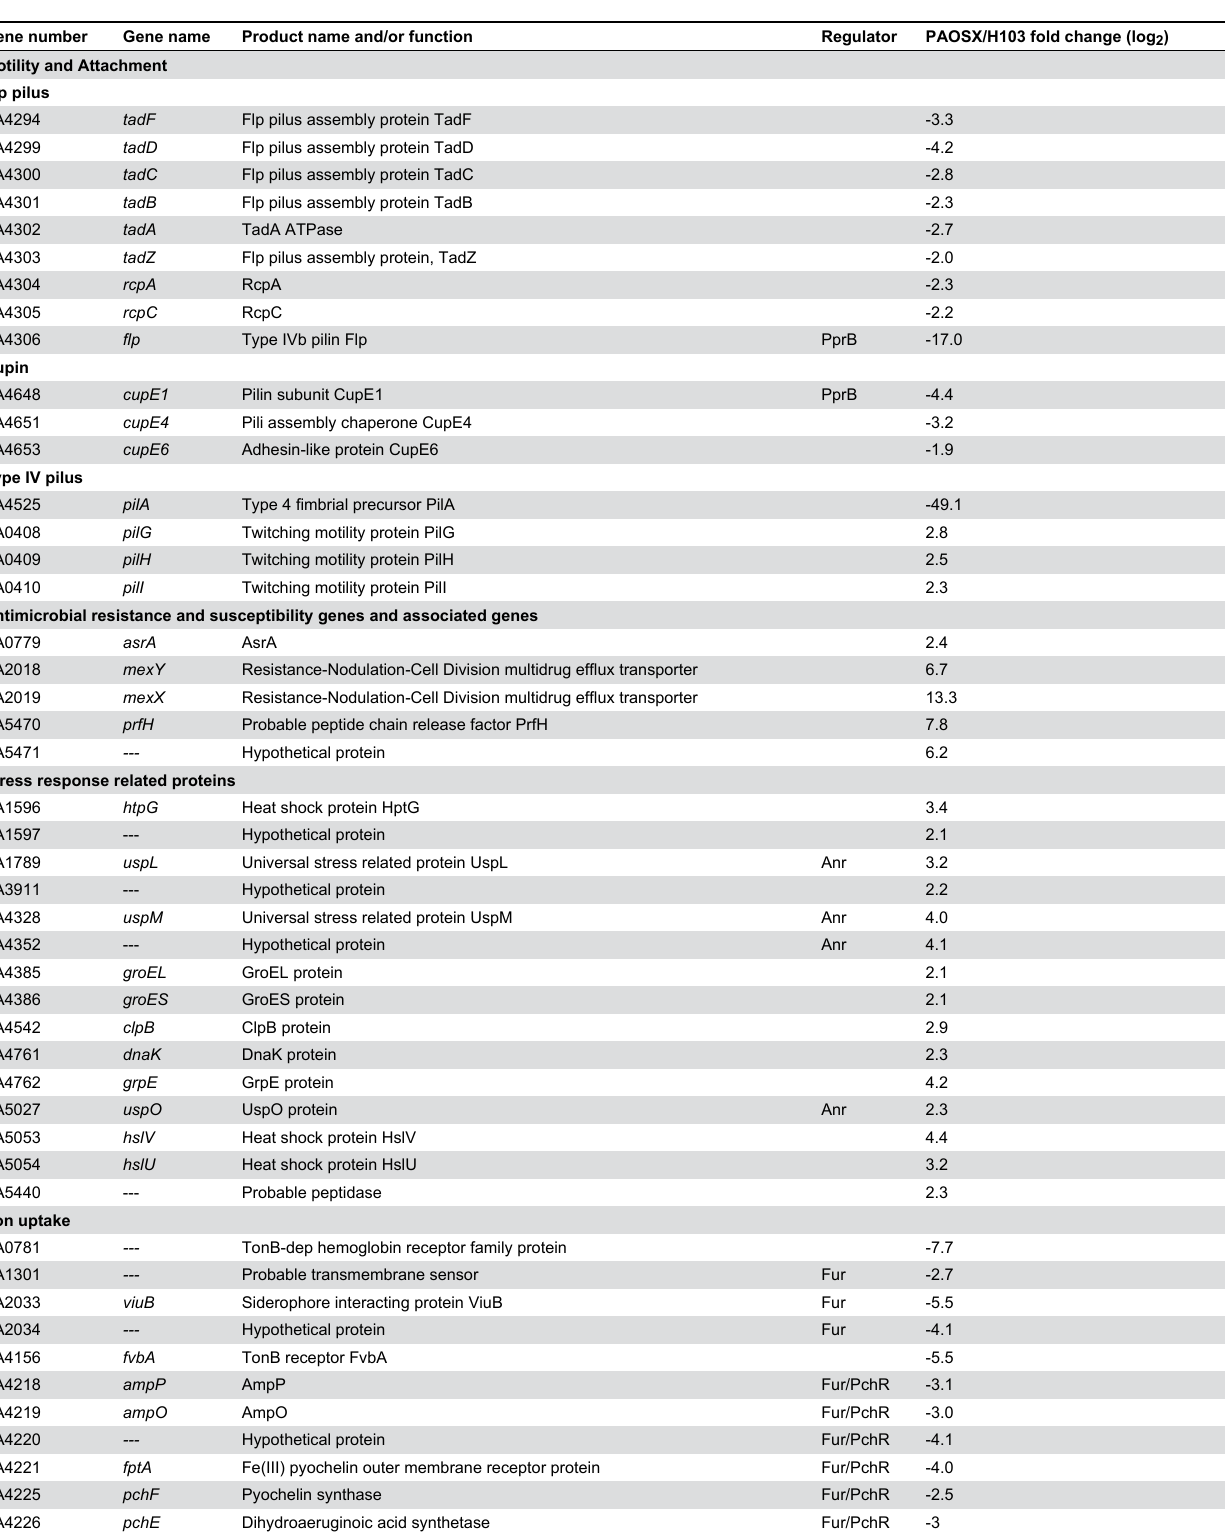
Table 2. Selected genes up- and down-regulated in P. aeruginosa PAOSX ( sigX mutant) versus H103 (WT).